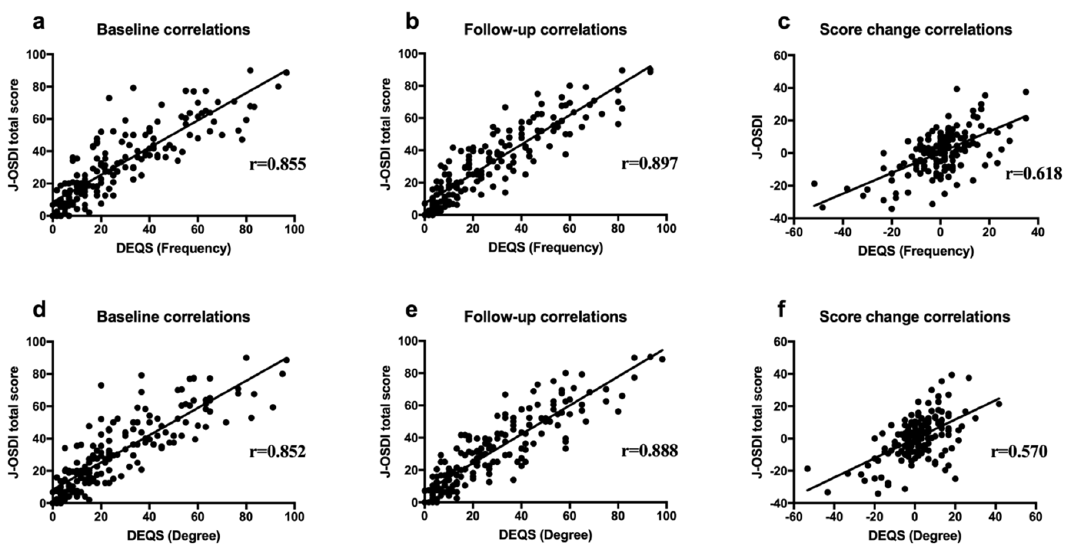
Figure 1. Correlation between the J-OSDI score and DEQS (Frequency and Degree) of patients with dry eye disease at the baseline and follow-up visits. Figure 1 shows the correlation between the J-OSDI total score and DEQS (Frequency) ( a – c ) and DEQS (Degree) ( d – f ) at the baseline and follow-up visits. The score changes between the baseline and follow-up visits were compared between the J-OSDI total score and DEQS (Frequency) ( a – c ) and DEQS (Degree) ( d – f ). J-OSDI: Japanese version of Ocular Surface Disease Index, DEQS: Dry Eye-Related Quality Score.